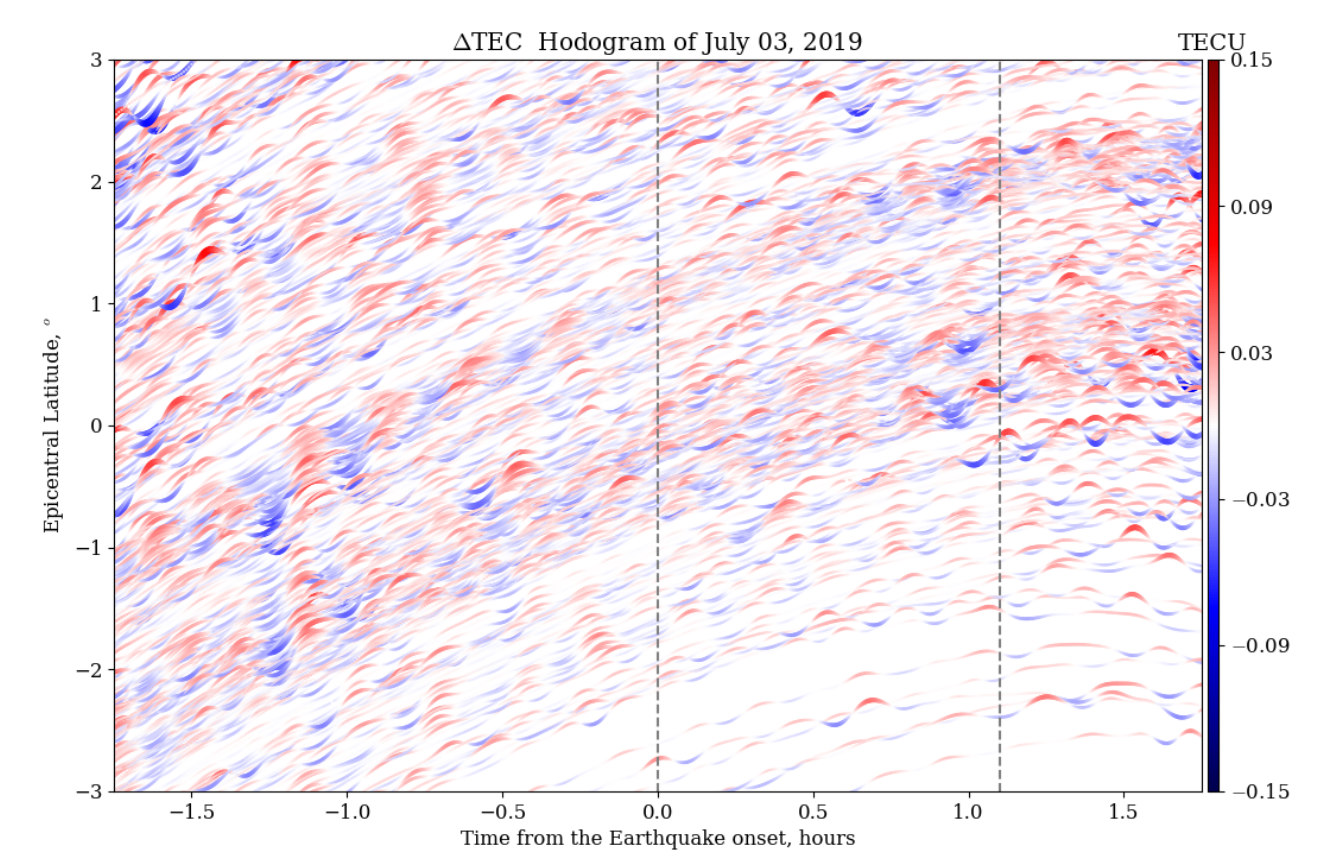
Figure 5. Hodogram of the observed ∆ TEC on the previous